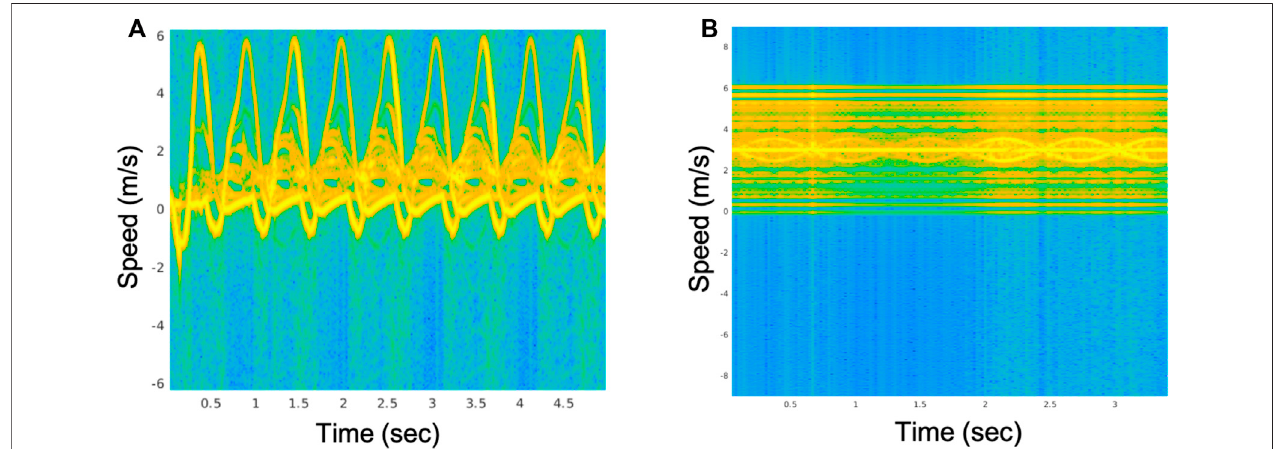
FIGURE 6 | Time-frequency analysis for a walking human (A) , and a cyclist (B) .